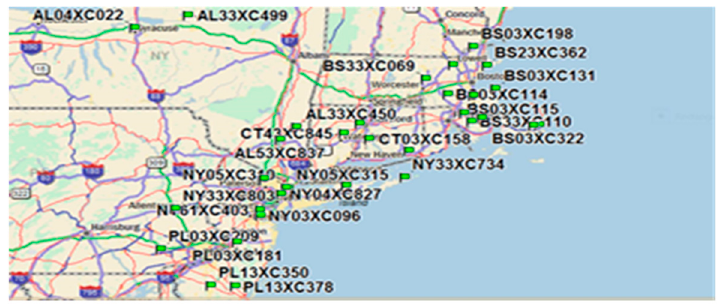
Figure 3. Measurement locations (University of Bridgeport, CT, USA).